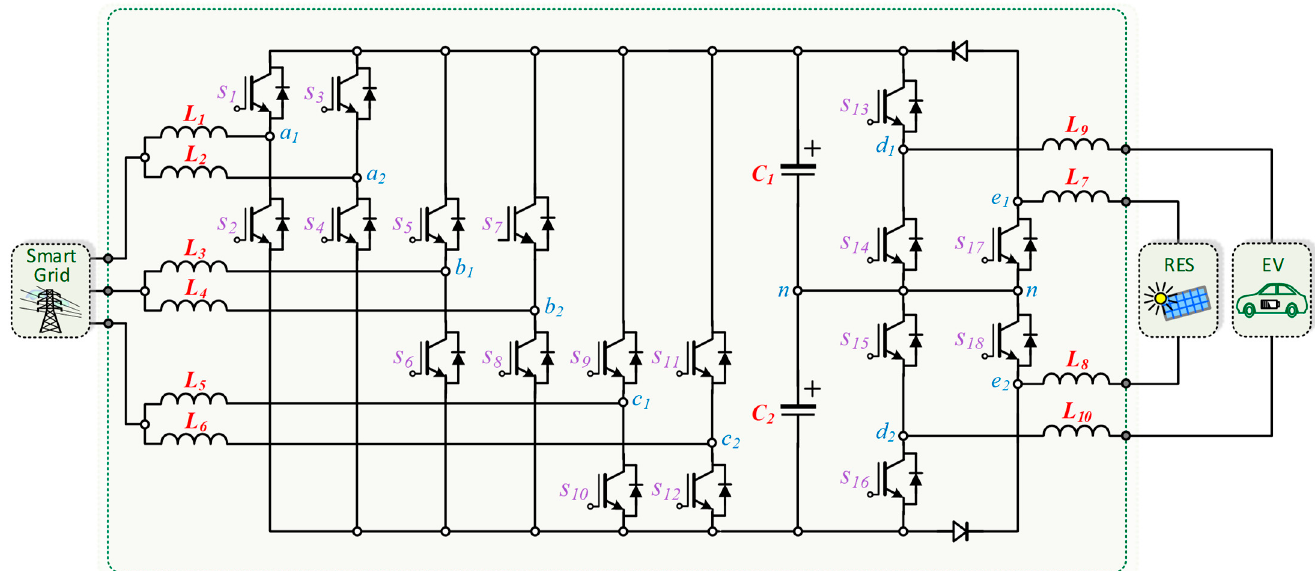
Figure 2. Proposed unified topology for the integration of electric vehicle, RES, and active power filtering for the power grid.